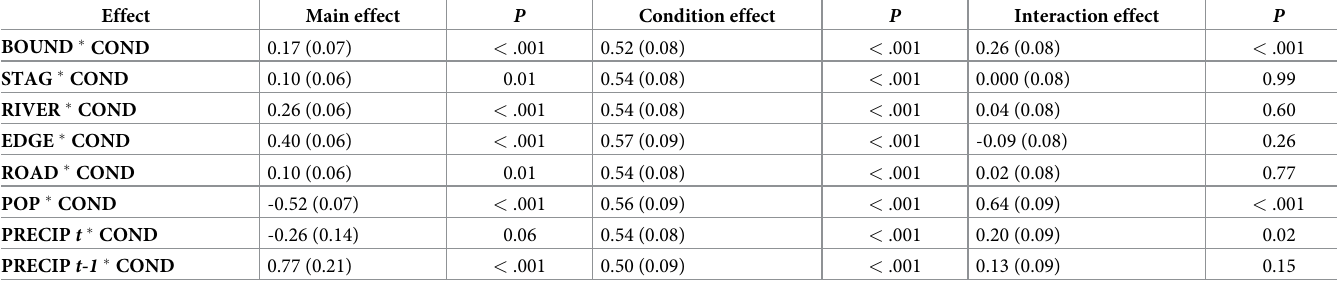
Table 2. Parameter estimates and standard errors (SE) for the interaction of Jamestown Canyon virus serostatus and environmental covariates describing suburban forest preserves in Cook County, Illinois (1996–1999). Significant ( α = 0.15) interaction terms identify variation in selection of the environmental covariate by serostatus (seronegative or seropositive for Jamestown Canyon virus).